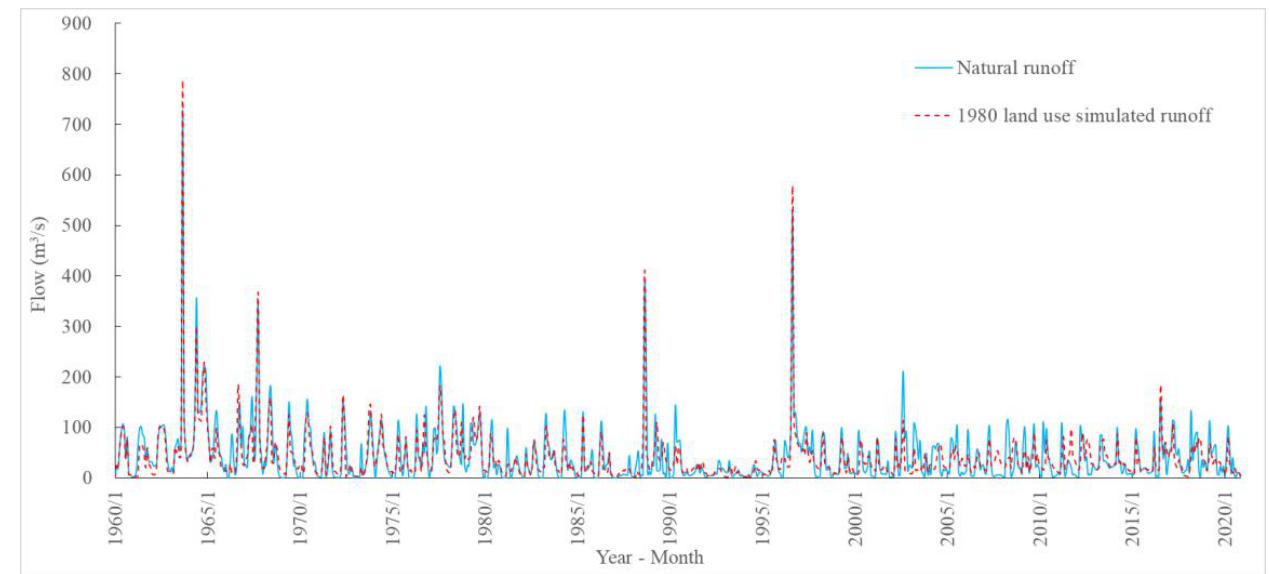
Figure 3. Comparison of simulated and natural runoff under the land-use scenario of 1980 at the Huangbizhuang Station.